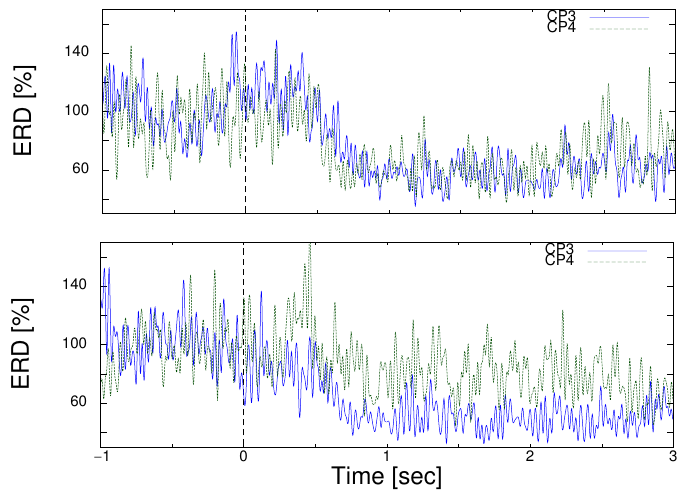
Figure 11. Event-related desynchronisation elicited by the motor imagery tasks of moving the left hand ( top ) and the right hand ( bottom ) at electrodes CP3 and